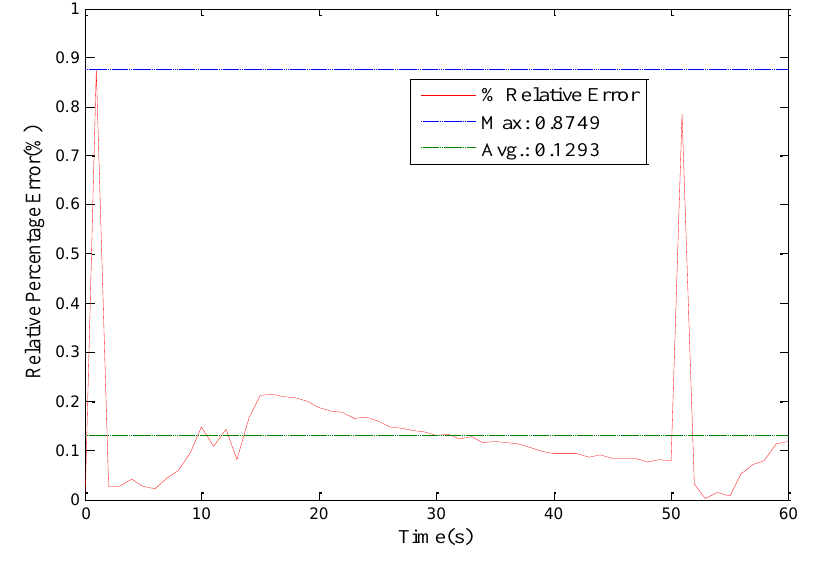
Figure 8. Relative error of the optimized battery model in HPPC test at 90% SoC.